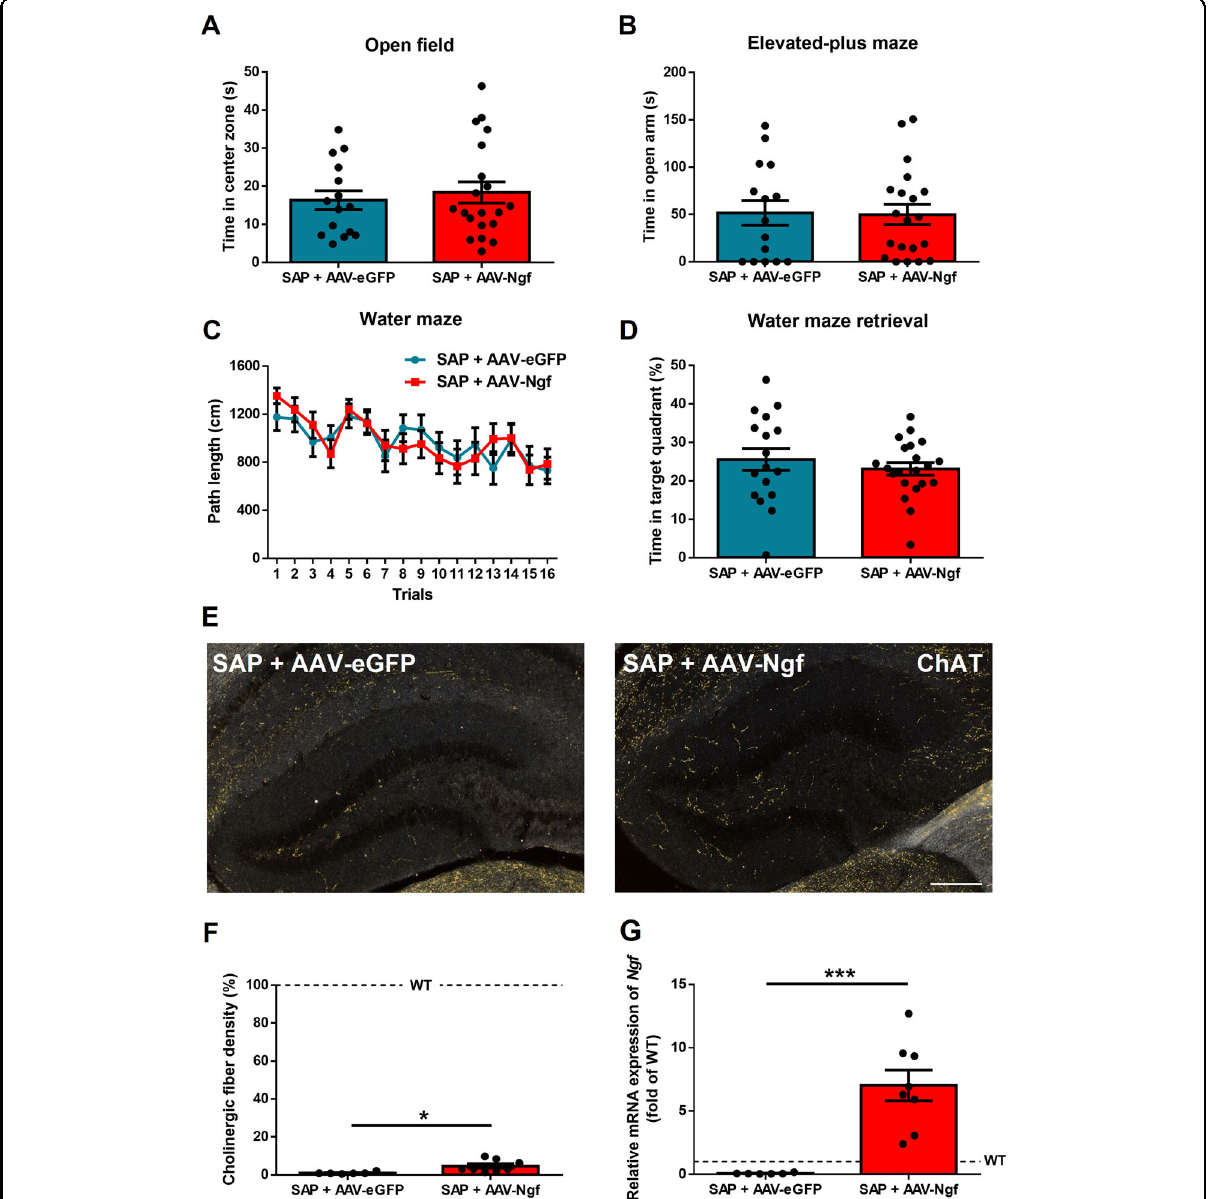
Fig. 5 Overexpression of hippocampal Ngf in knockout mice with cholinergic depletion cannot rescue spatial memory. A , B Hippocampal Ngf overexpression (AAV- Ngf ) in WT mice that had hippocampal cholinergic depletion using anti-p75 NTR Saporin had no effect on the open fi eld or elevated plus maze compared to hippocampal cholinergic-depleted mice given AAV-eGFP injection as control ( n = 15 – 20). C , D Ngf overexpression in hippocampal cholinergic-depleted mice did not affect spatial leaning or memory ( n = 19 – 21). E , F ChAT staining con fi rmed cholinergic depletion in both groups. G We con fi rmed the Ngf overexpression by real-time PCR ( n = 6 – 8). Dotted lines represent the levels of age-matched WT naive